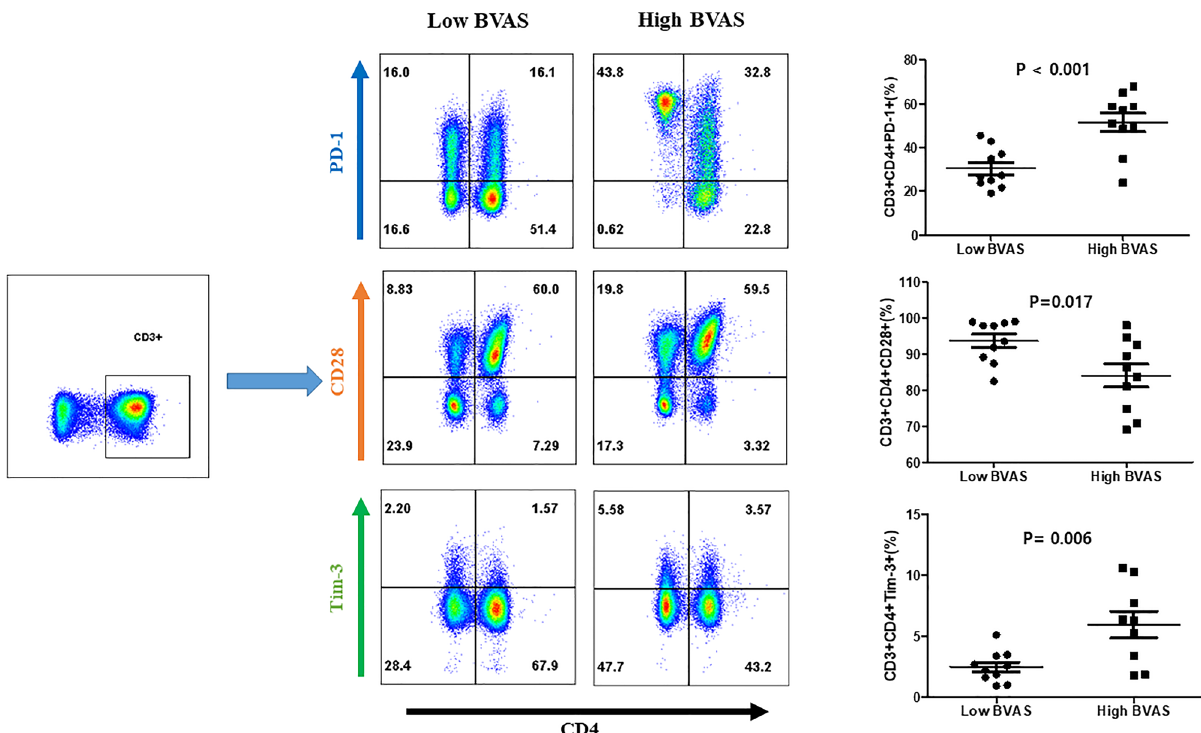
Figure 3. Comparison of the population of T cells expressing CD28 between patients with AAV with low BVAS and those with high BVAS. Patients with AAV with a high BVAS showed a significantly higher population of CD3 + CD4 + PD1 + T cells as well as CD3 + CD4 + Tim3 + T cells and a lower population of CD3 + CD4 + CD28 + T cells than those with a low BVAS. Plots show median, with error bars indicating ± interquartile range. AAV ANCA-associated vasculitis, ANCA Antineutrophil cytoplasmic antibody, BVAS Birmingham vasculitis activity score, PD Programmed cell death, Tim-3 T-cell immunoglobulin and mucin-domain